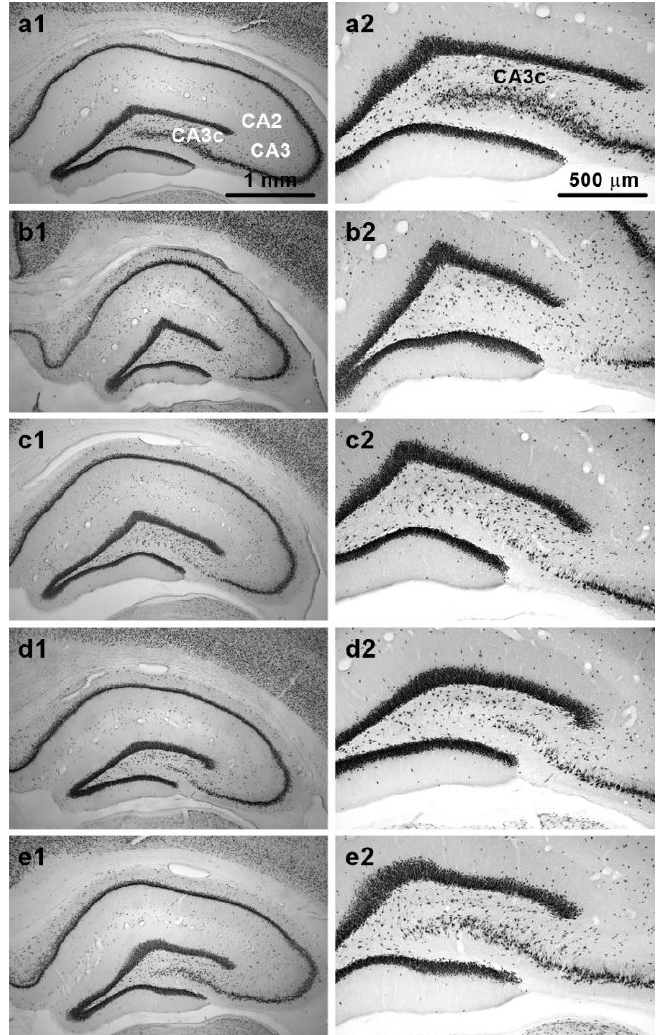
Figure 5. Representative NeuN-stained sections from dorsal hippocampus. Panels show sections from animals treated with: ( a1 , a2 ) Saline (relevant subfields of pyramidal cell layer are marked); ( b1 , b2 ) TMT (note almost complete neuronal loss in CA3c); ( c1 , c2 ) TMT + MK-801; ( d1 , d2 ) TMT + midazolam; ( e1 , e2 ) TMT + MK-801 + midazolam. Note different neuronal densities in CA3c. Sections from animals with neuronal density close to the group mean are depicted. Magnification: 4 × (left panels); 10 × (right panels). Microphotographs in Figure 5 were acquired using a microscope (left panels: Zeiss Axio Observer D1, 4 × /0.1 objective lens; right panels: Olympus BX53, 10 × /0.40 dry objective lens) connected to a camera (Olympus DP74 for the Olympus BX53 microscope, and Zeiss AxioCam MRm for the Zeiss microscope) and acquisition system in brightfield illumination in grayscale camera